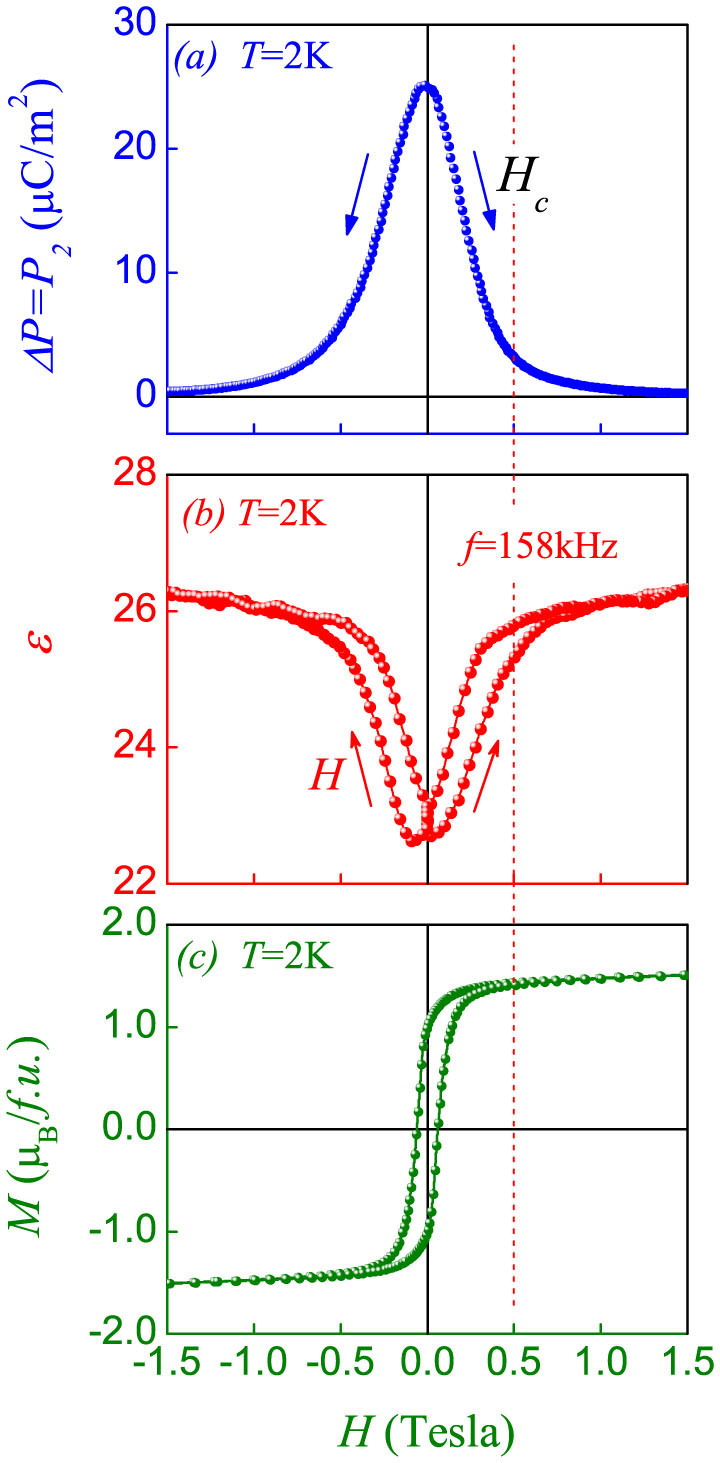
Measured (a) ΔP (P2)-H data (b) ε-H data, and (c) M-H hysteresis loop at T = 2 K.